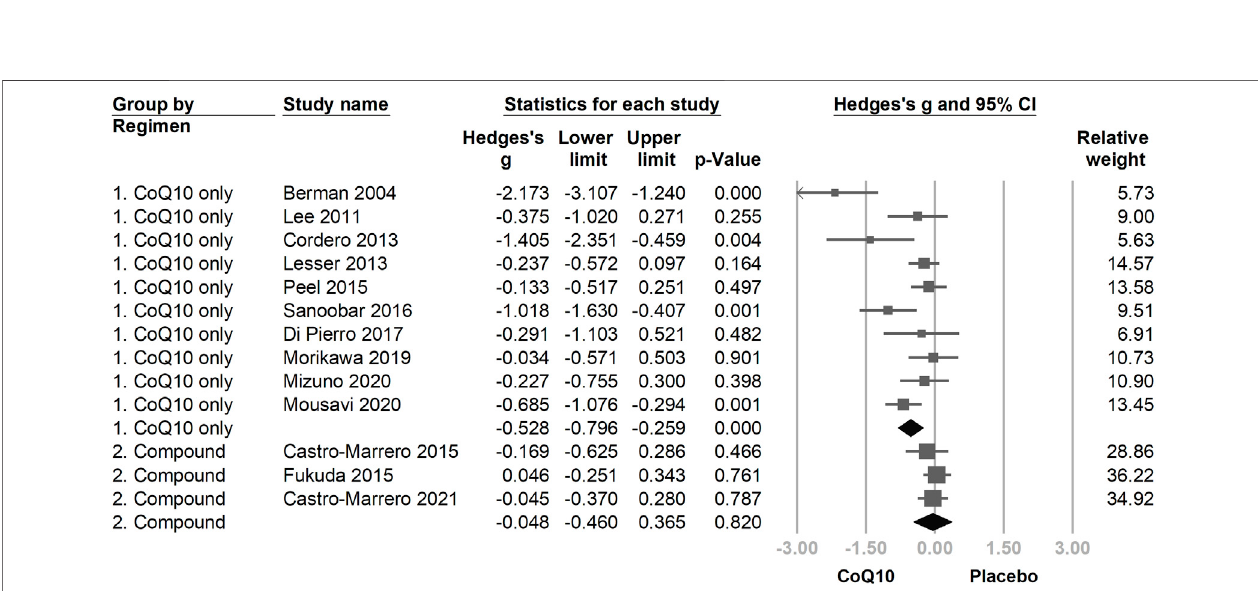
FIGURE 5 | The forest plot of subgroup analysis using the participants ’ condition as the moderator, including healthy participants and patients with disease. The directions of association between the use of coenzyme Q10 (CoQ10) and fatigue assessment were consistent in the subgroups, with overlapping 95% con fi dence intervals (CIs).